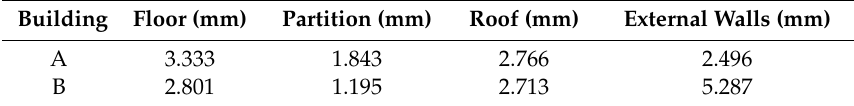
Table 10. Various PCM thicknesses used in the structure components (SCs) of the building.